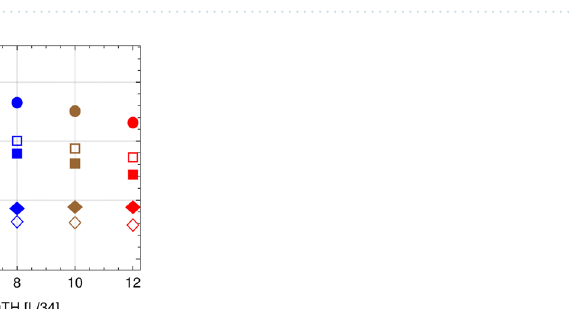
2500 (cid:31) 2 / mL 2 Figure 5. Left frame: Superfluid fraction as a function of temperature (black dots) for µ = 0.56 (vertical dotted (from 22 ). Initially, i.e. before perturbation, the system is prepared at temperature T / T c = 14 / 16 and the widths w / L ( 2, 4, 6, 8, 10, 12 )/ 34 line, most left). After density imprinting with the depth d = = the system’s relative temperature is shifted up (shown by successive vertical lines). The vertical dashed line, most right, shows the transition temperature. Middle frame: Number of pairs of opposite charge vortices (averaged over 100 realizations; error bars denote the standard deviations) versus time, for various perturbations as in the left frame. Stronger perturbation leads to larger number of vortices at equilibrium, i.e. at longer times 0.20mL 2 / (cid:31) ( 1.0mL 2 / (cid:31) in inset) corresponds to and to larger standard deviations. Total evolution time t = 400 ms ( 2 s ) for L 38 µ m . Right frame: Decay of the number of vortex pairs N v as a function of time, here for = 1 (black solid line) and t 2 / 5 (blue solid line) dependence. 12 / 34 , exhibiting two characteristic regimes: t w / L − − =